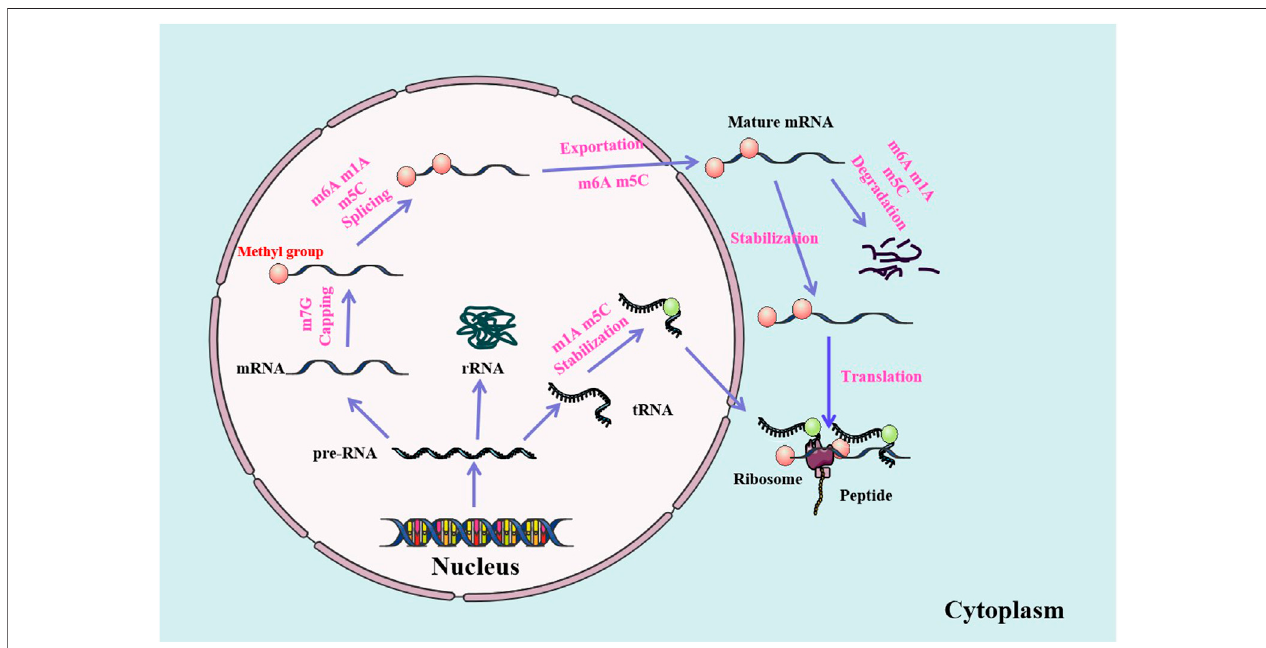
FIGURE2| RNAmethylationsareinvolvedinthemodi fi cationsandmetabolismofRNAmolecules.RNAmethylationsmodifythestructure ofRNAsandparticipate in the regulation of RNA metabolism, including RNA termination, splicing, stabilization, nuclear export, translation and degradation.